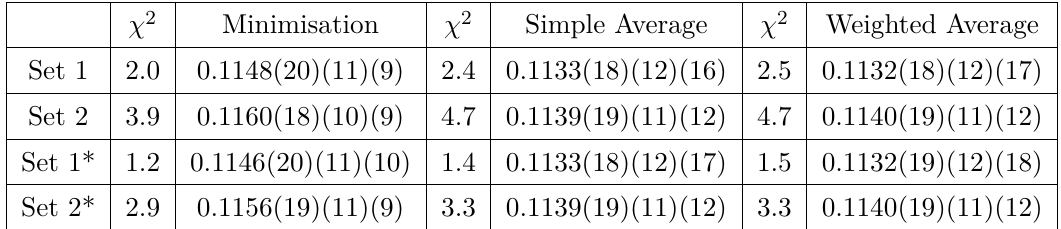
) obtained when the theory uncertainty from O 6 is Z